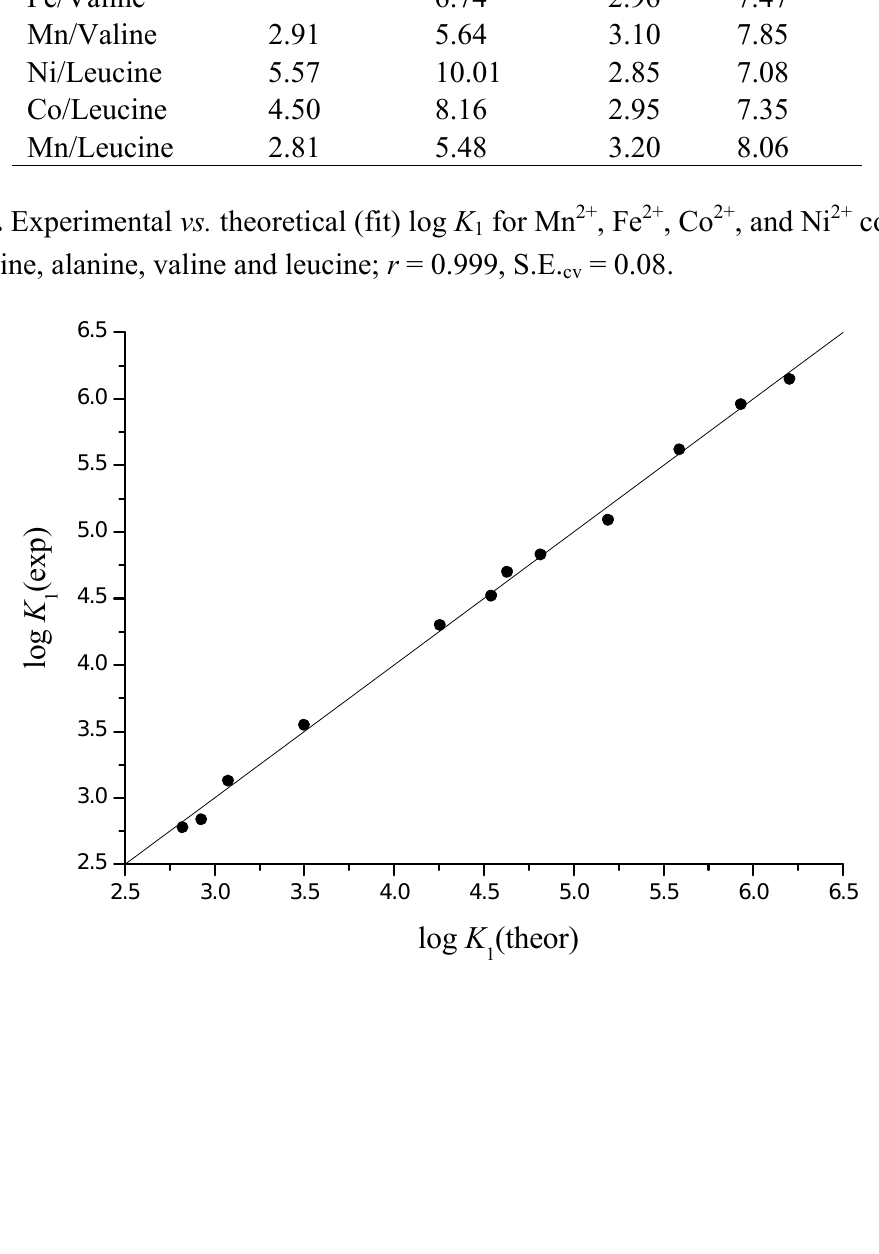
Figure 5. Experimental vs. theoretical (fit) log K with glycine, alanine, valine and leucine; r = 0.999, S.E.